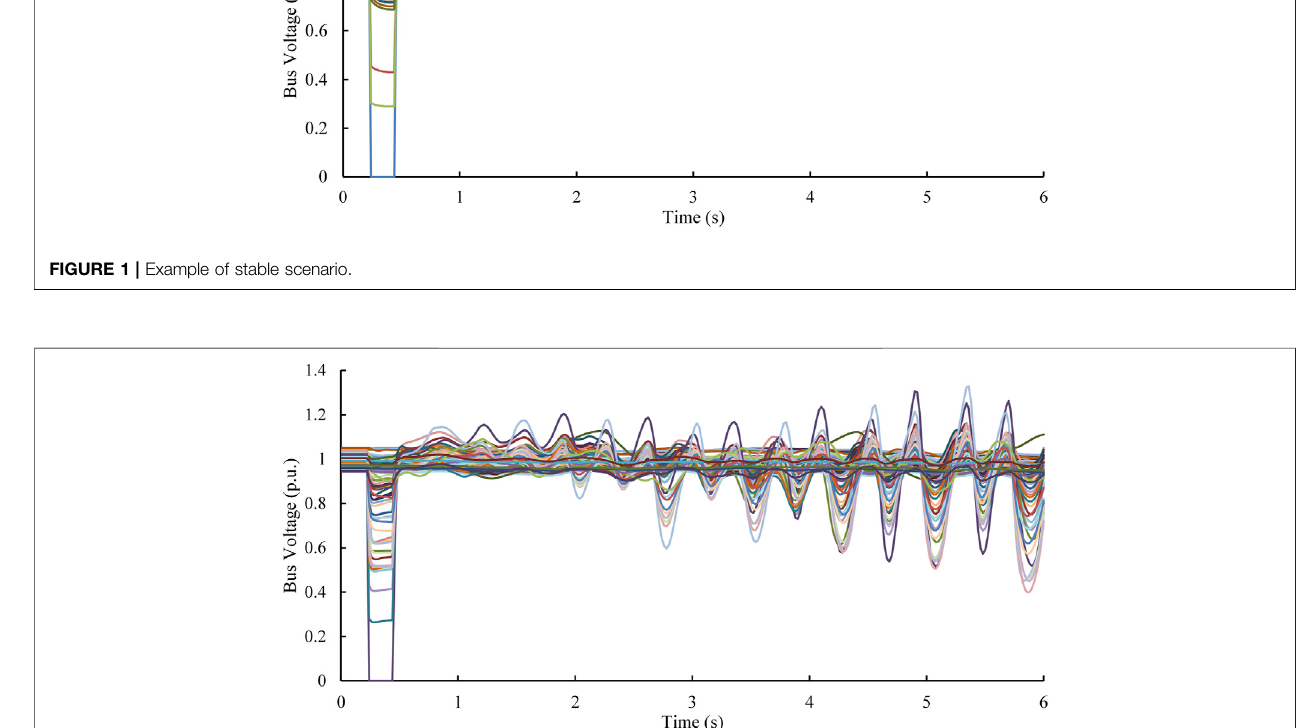
FIGURE 2 | Example of unstable scenario.